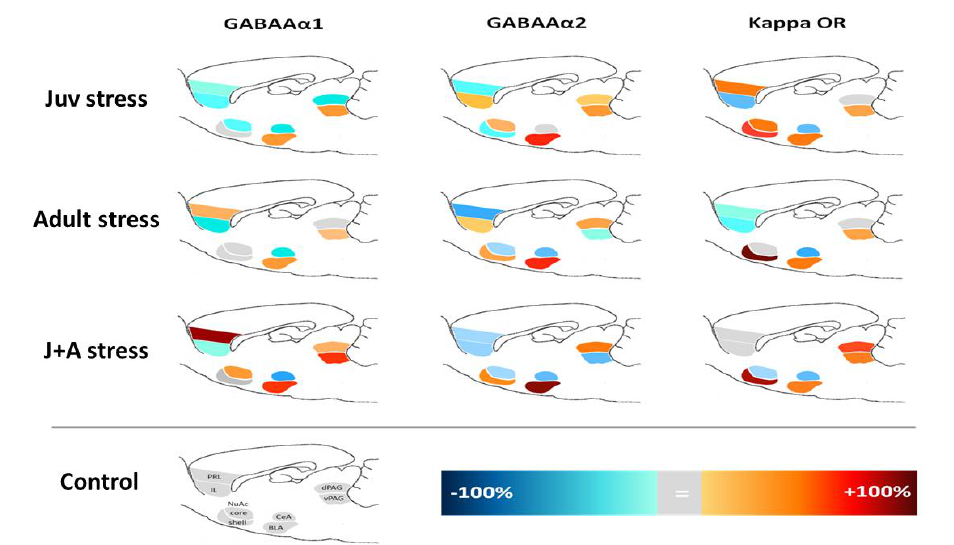
Figure 5. A combined map of γ -Aminobutyric acid type A (GABAA) and κ -opioid receptors (KOR) expression in a fear memory-related network of regions: Warm colors represent a positive shift from control group values, while cold colors represent a negative shift. The gray color represents no differences from the control. PRL, prelimbic; IL, infralimbic; NuAc, nucleus accumbens; CeA, central amygdala; BLA, basolateral amygdala; PAG, periaqueductal gray. (Control: n = 13; juv stress: n = 11; adult stress: n = 13; and J + A stress: n = 14.)